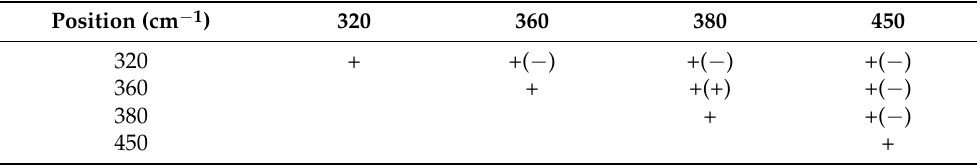
Table 3. 2D-COS fluorescence analysis results of the sign of each cross-peak in the synchronous ( Φ ) and asynchronous ( Ψ ) maps of PA-derived DOM samples at different temperatures.